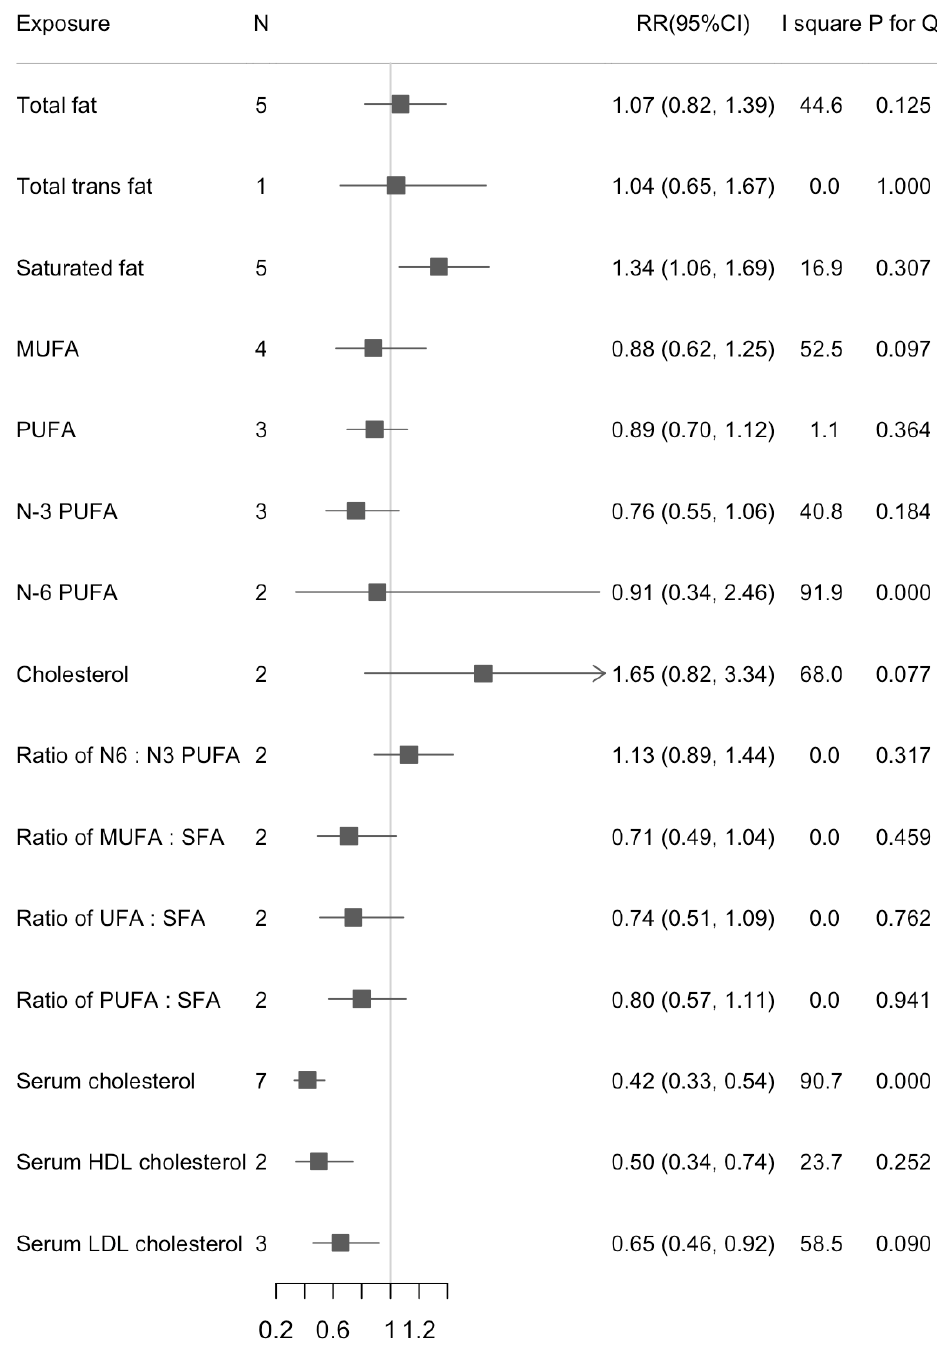
Figure 2. Summary of associations between dietary fats and serum cholesterol and liver cancer (Highest versus lowest categories).